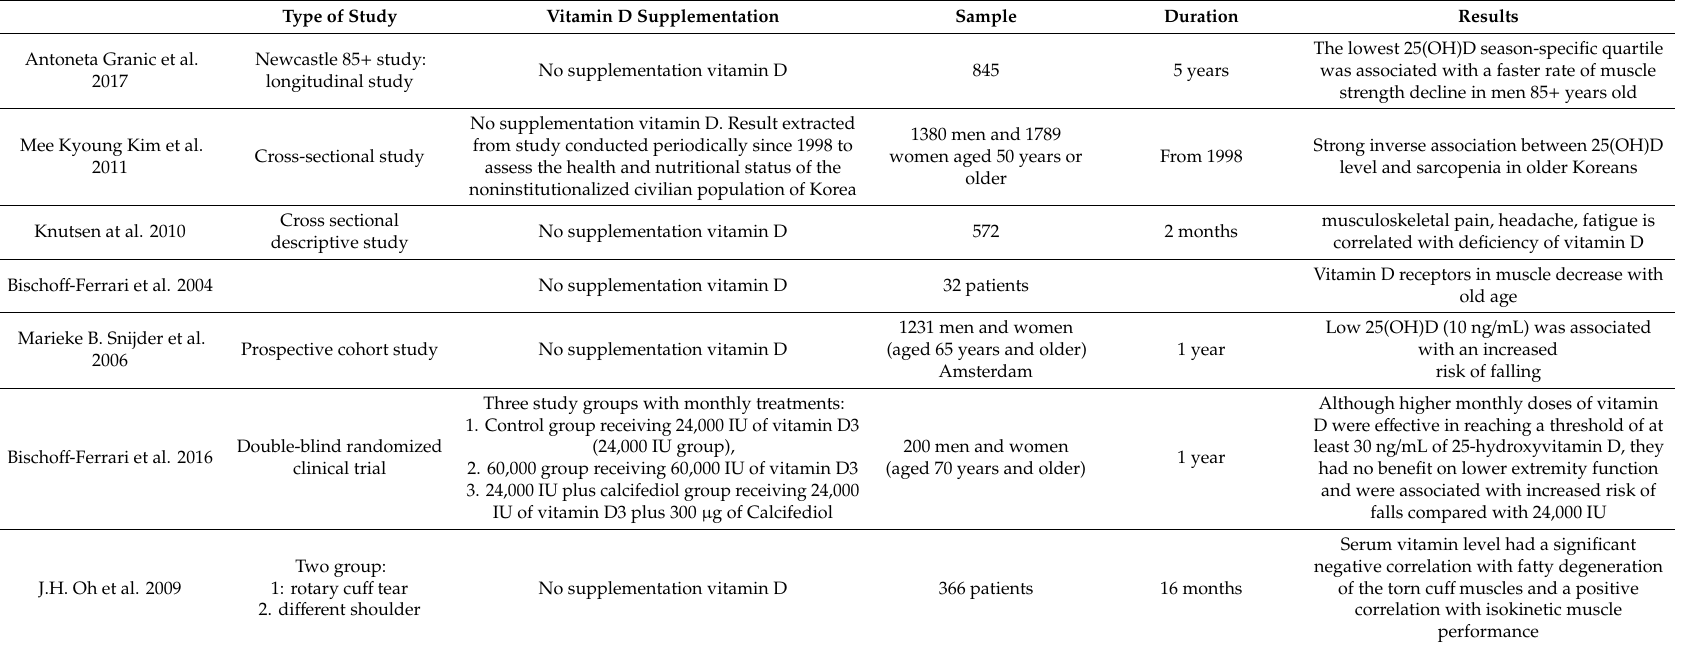
Table 3. Summary of studies on vitamin D considered in this narrative